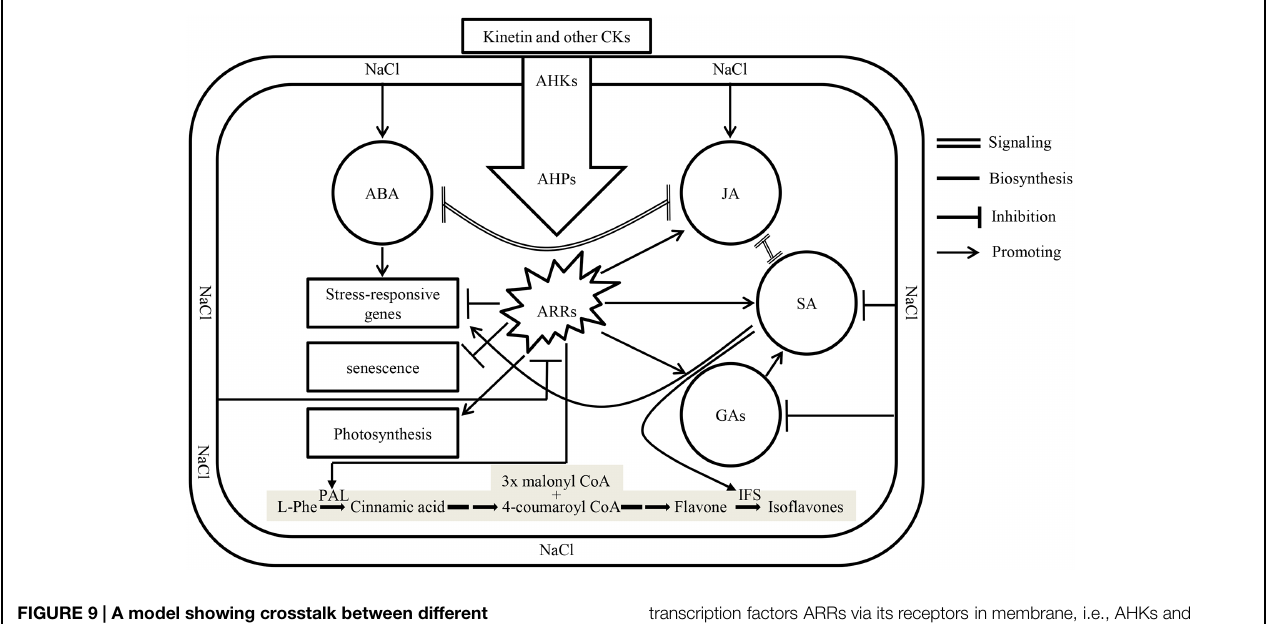
transcription factors ARRs via its receptors in membrane, i.e., AHKs and downstream response regulators AHPs thereby delaying senescence, restoring photosynthesis and enhancing the biosynthesis of GAs, SA, and JA accompanied by decline in ABA concentration and signaling. The shaded pathway is indicating the biosynthesis of isoflavones in legumes, where the expression of two key enzymes, phenylalanine ammonia lyase (PAL) and isoflavone synthase (IFS) is induced by CKs and SA,